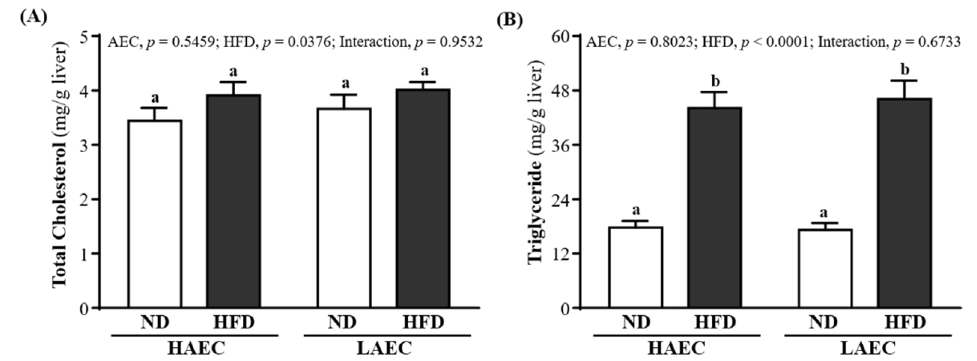
Figure 5. Effects of 12 weeks’ HFD feeding of HAEC or LAEC postpartum mice on: ( A ) hepatic TC; and ( B ) TG levels. Data are mean ± SEM for n = 8 mice per group. Columns with different superscript letters (a, b) are significantly different between groups at p < 0.05.